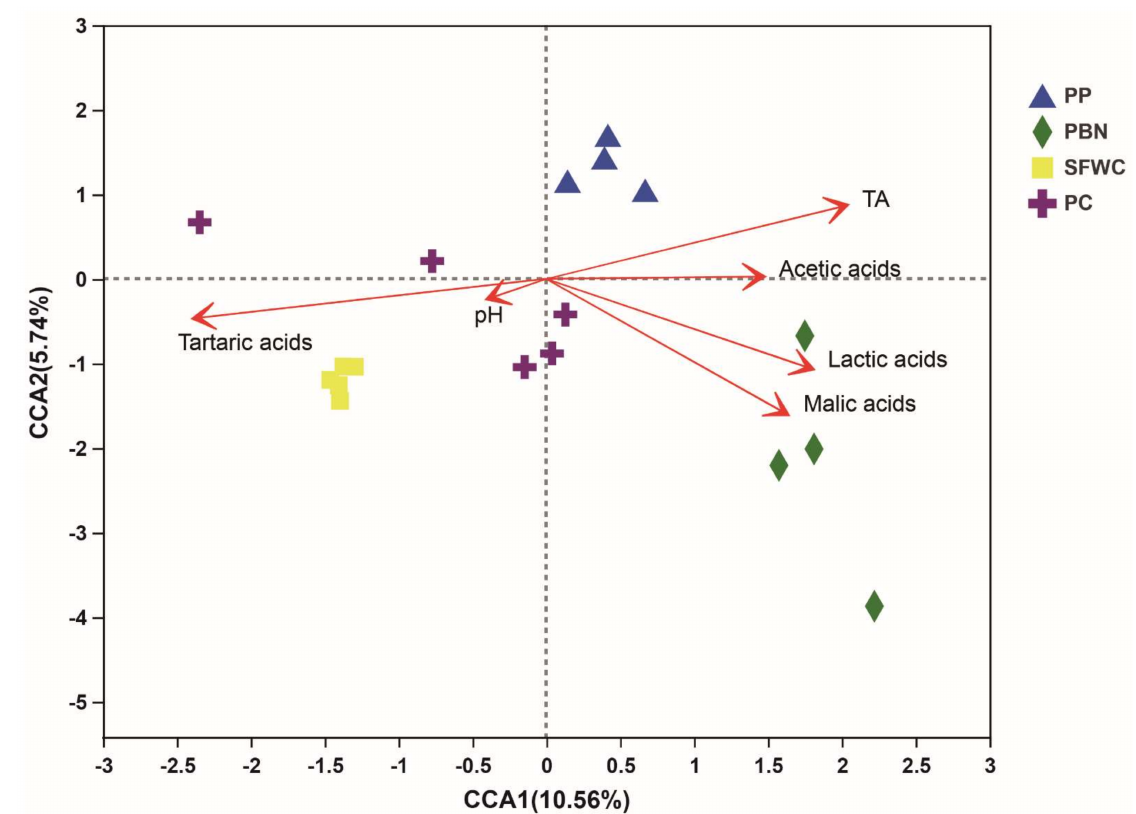
Figure 6. Canonical correlation analysis (CCA) of four traditional fermented vegetables